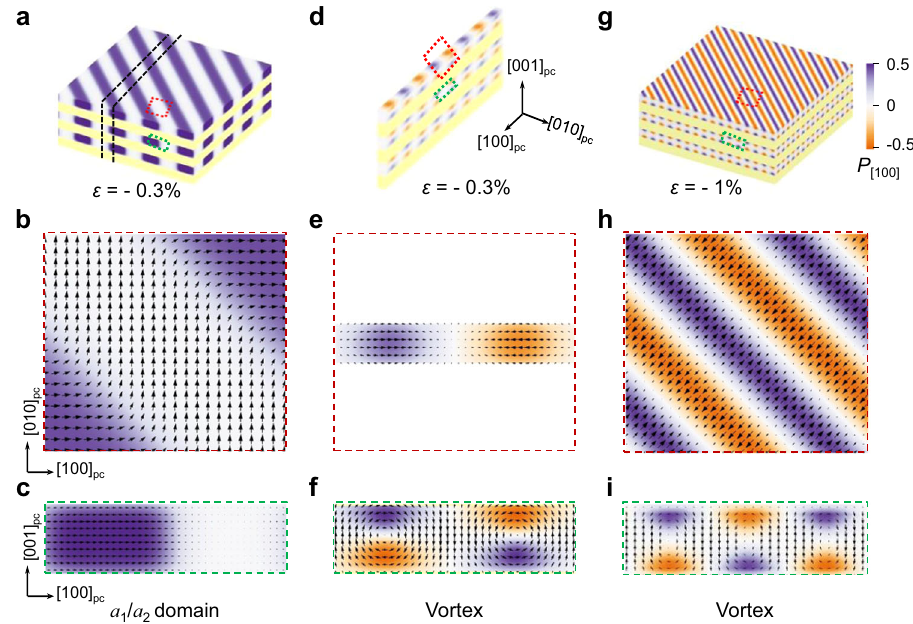
Fig. 4 Phase- fi eld simulation of (PTO) 10 /(STO) 10 superlattice. a Spatial distribution of polarization with equiaxial strain ε ¼ (cid:3) 0 : 3 % , showing the a 1 / a 2 domain structure. Periodic boundary conditions are applied along [100] pc , [010] pc and [001] pc directions, respectively. b , c Zoom-in results corresponding to the area labeled by red and green rectangles in ( a ). d The slices cut from ( a ) within the black dotted lines, showing reconstructed vortex structure. The thickness of the slices is 2.4 nm. e , f Zoom-in results for the vortex structure labeled by the red and green rectangles in ( d ), respectively. g Spatial distribution of polarization with biaxial strain ε ¼ (cid:3) 1 % , showing the vortex structure. h , i Zoom-in results corresponding to the representative areas labeled by red and green rectangles,